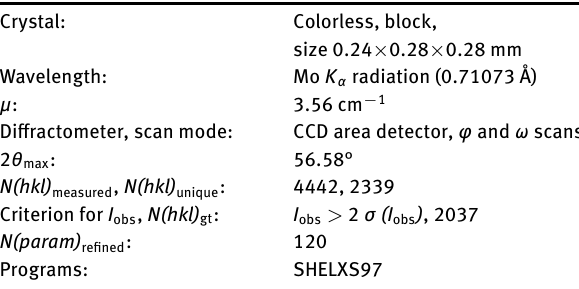
tions [C—H = 0.96 (methyl), 0.97 (methylene) and 0.93 Å (aromatic)] and included in the refinement in the riding model approximation, with U (H) = 1.5 U eq (methyl C) iso